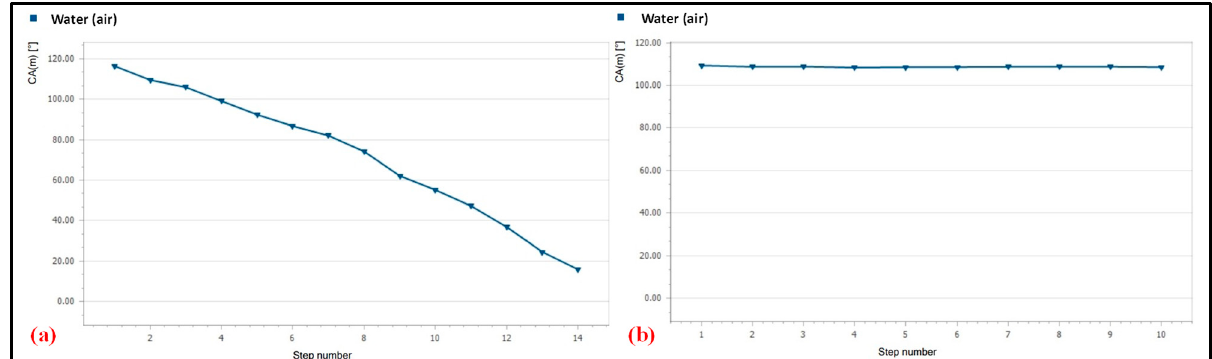
Figure 9. Contact angle retention after an ( a ) single (cid:3398) stroke or ( b ) double ‐ stroke.